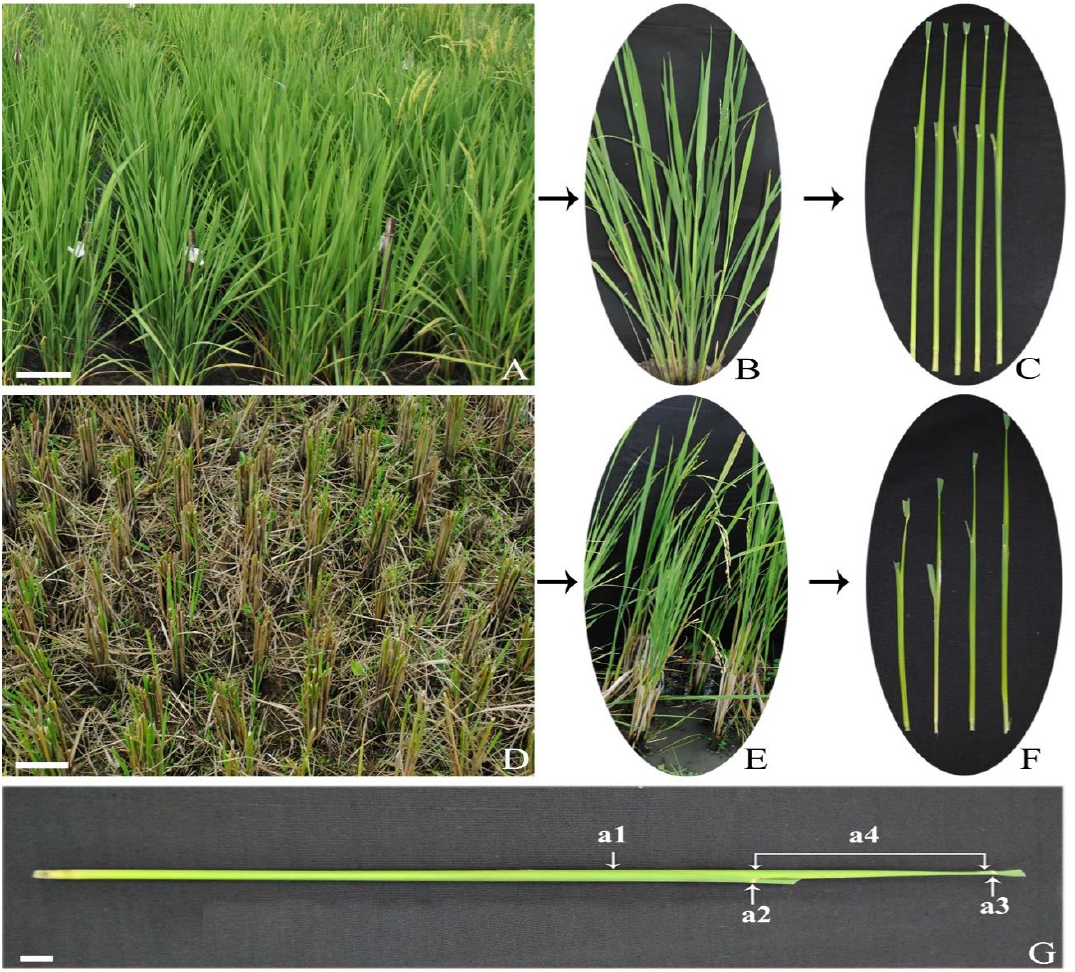
Figure 3. Explants sources. ( A ) Non-ratooned plants (bar 15 cm). ( B ) Close view of a single parent plant bearing fertile tillers. ( C ) Boots collected from the main crops. ( D ) Ratooned plants in field (bar 15 cm). ( E ) Close view of ratooned crop bearing boots. ( F ) Boots collected from the ratooned crops. ( G ) A panicle boot measured for the internode distance: (a1) leaf sheath-enclosed panicle, (a2) node of the penultimate leaf, (a3) node of the flag leaf, (a4) internode distance (bar 2 cm).